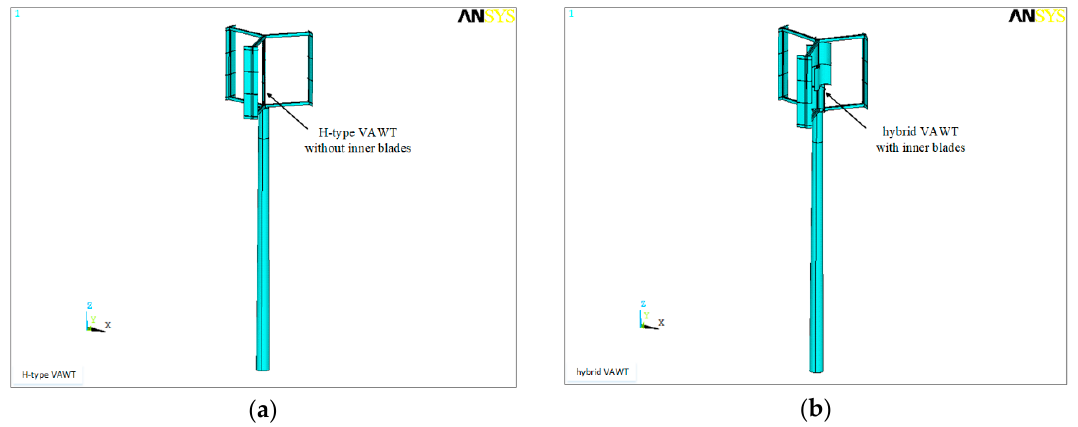
Figure 1. Shapes of the ( a ) H ‐ type and ( b ) hybrid VAWTs, where the hybrid VAWT has inner blades and the H ‐ type VAWT does not have them.